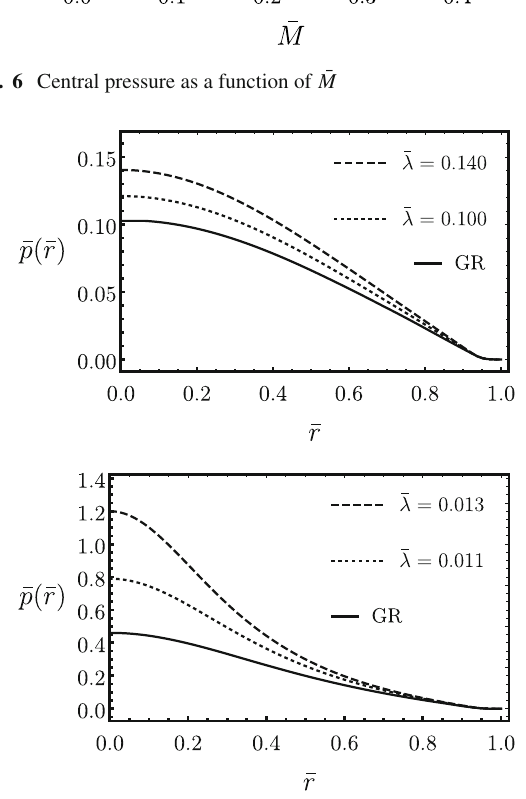
Fig. 7 Dependence of ¯ p with ¯ r , for ¯ ρ 0 = 0 . 100 (upper panel), and ¯ ρ = 0 . 113 (lower 0